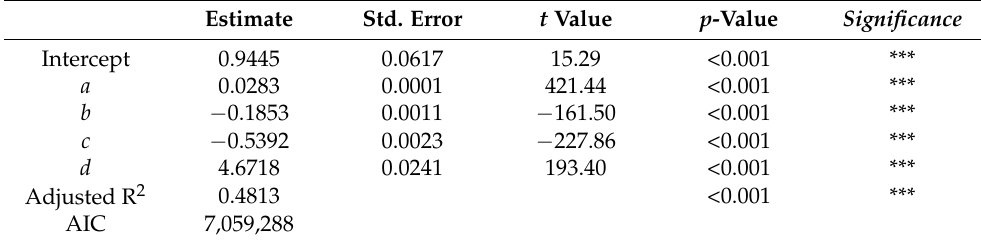
Table 1. Linear SIR Regression estimated by Equation (8).